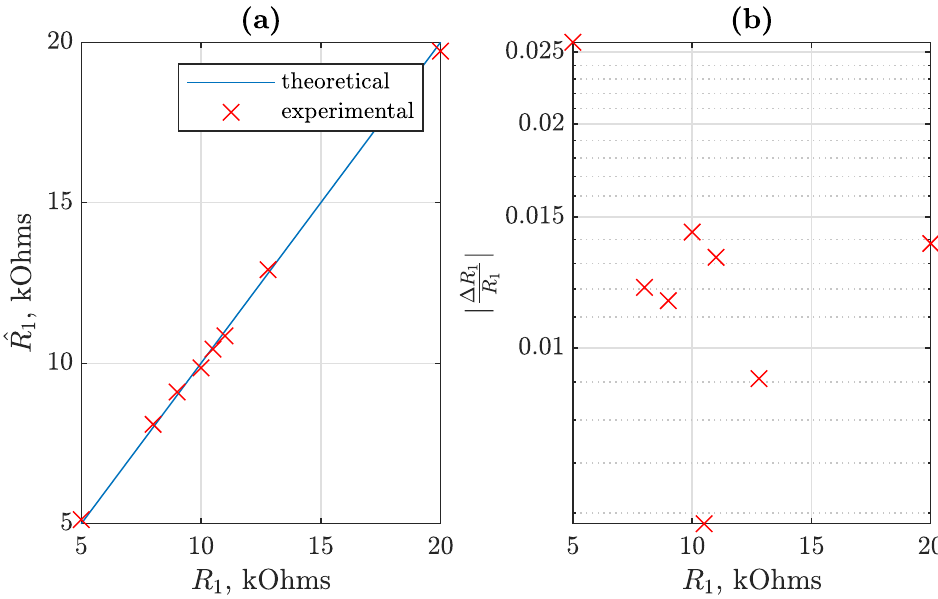
Figure 15. ( a ) Resistance R 1 identification results; ( b ) Evaluation of relative error in R 1 identifi- cation: the plot shows the actual R 1 value versus the relative error of its estimation | ∆ R = ˆ R − R 1 1 1